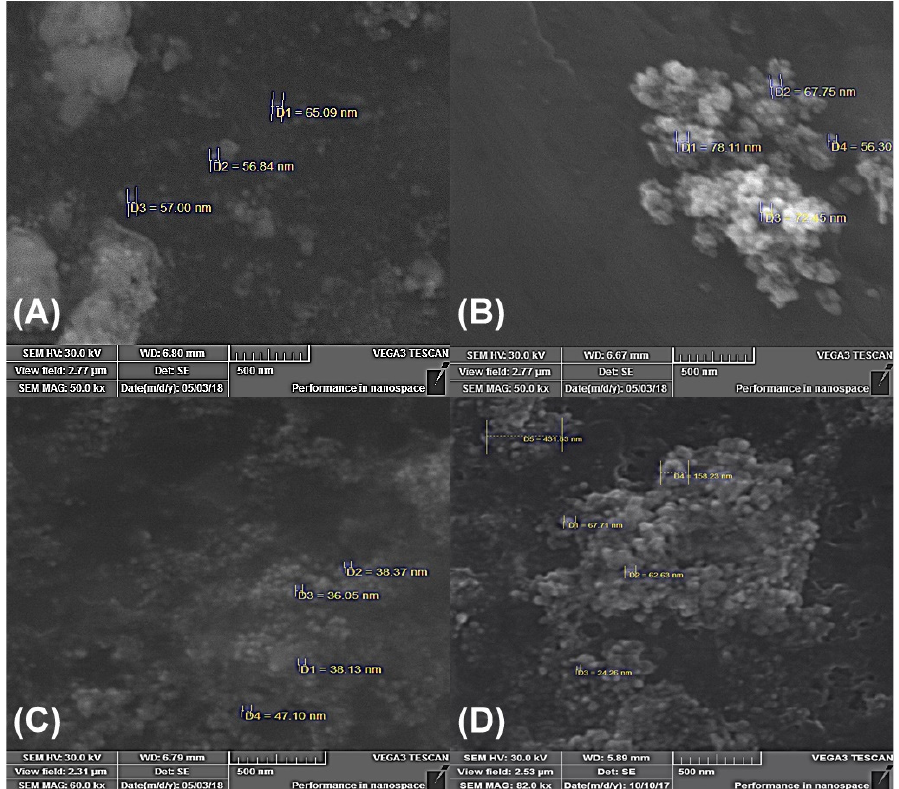
Figure 2. SEM analysis of obtained AgNPs. ( A ) Geobacillus sp. 18; ( B ) Geobacillus sp. 25; ( C ) Geobacillus sp. 95; ( D ) Geobacillus sp. 612. Table 1. Values of the zeta potential (mV) of AgNPs obtained using secretomes of four different Geobacillus spp. strains. Tested Strain of Geobacillus spp.